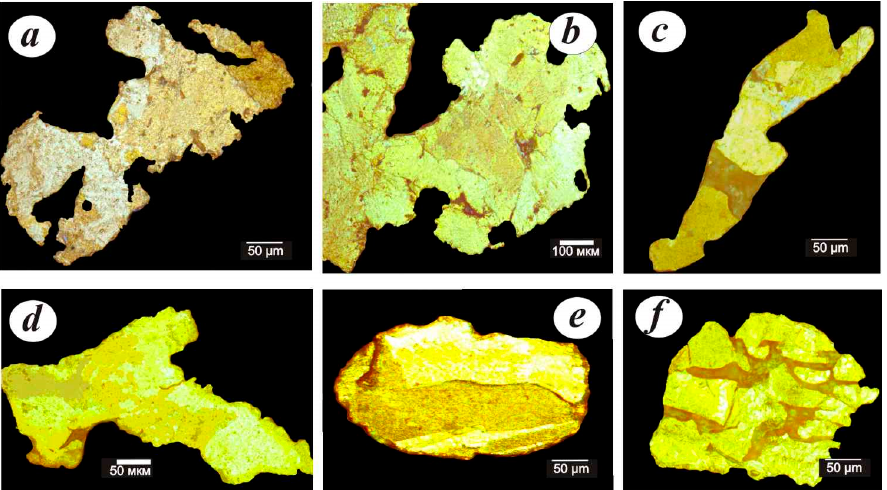
Figure 3. Internal structures of placer gold of the Mesozoic stage of ore formation (Upper Amga river basin): ( a ) coarse-grained structure of high-grade gold; ( b ) inequigranular structure of high-grade gold with manifested granulation; ( c ) the inequigranular structure of high-grade lamellar gold (930–980‰); ( d ) emulsion intergrowth of three phases of gold close to the fineness (light yellow—950 ‰; yellow—890‰; dark yellow—999‰); ( e ) polygonal intergrowth of two phases of native gold: light yellow—fineness 900‰, dark yellow—999‰; ( f ) polygonal-grained structure of high-grade native gold (940‰) in intergrowth with quartz-hematite-limonite composition.